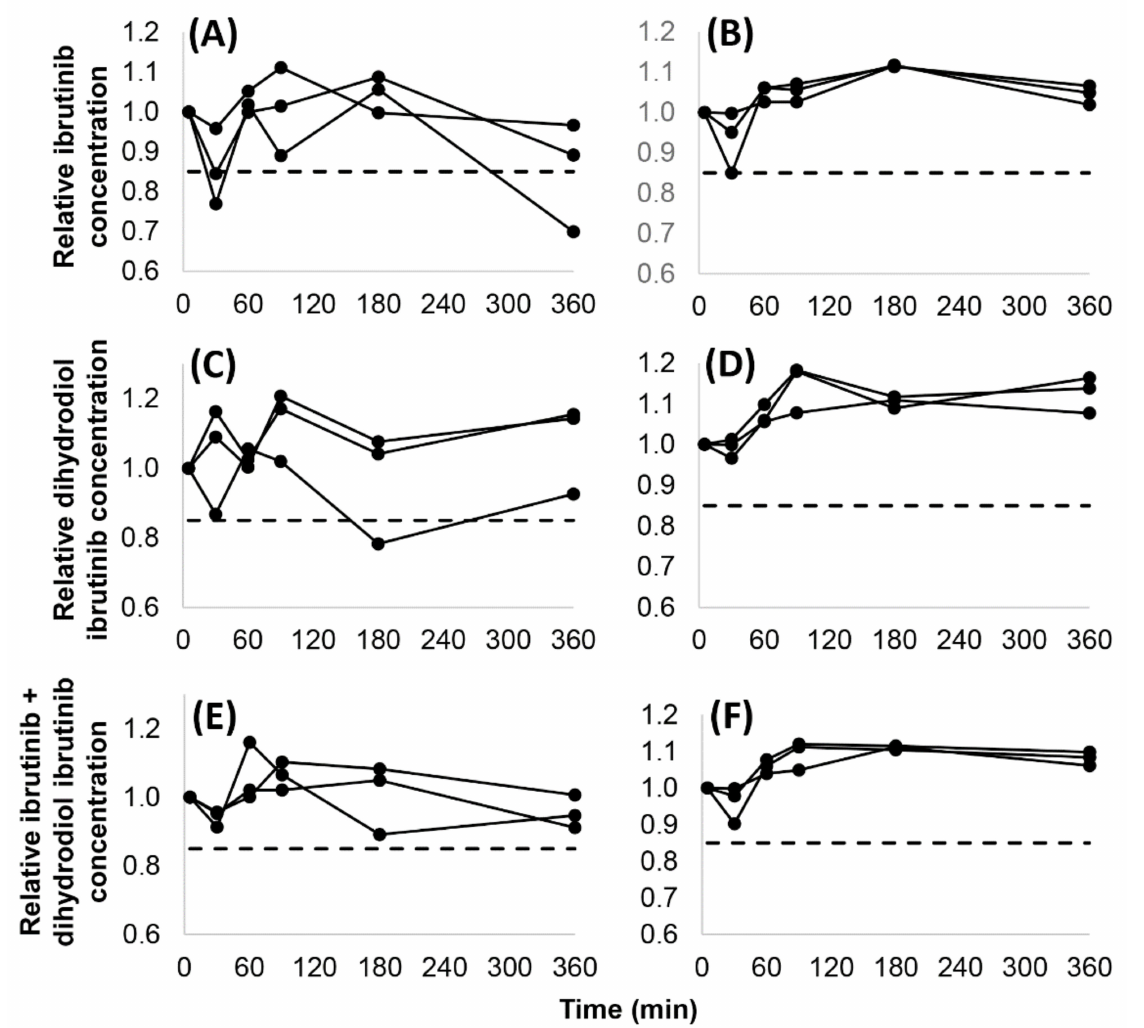
Figure 2. Stability of ibrutinib ( A , B ), dihydrodiol ibrutinib ( C , D ) and the active moiety (sum of ibrutinib and dihydrodiol ibrutinib concentrations) ( E , F ) in whole blood ( A , C , E ) and in plasma ( B , D , F ) at 25 ◦ C over 6 h in 3 independent samples. The dashed line ( - - - ) displays the limit for judging analyte stability as acceptable